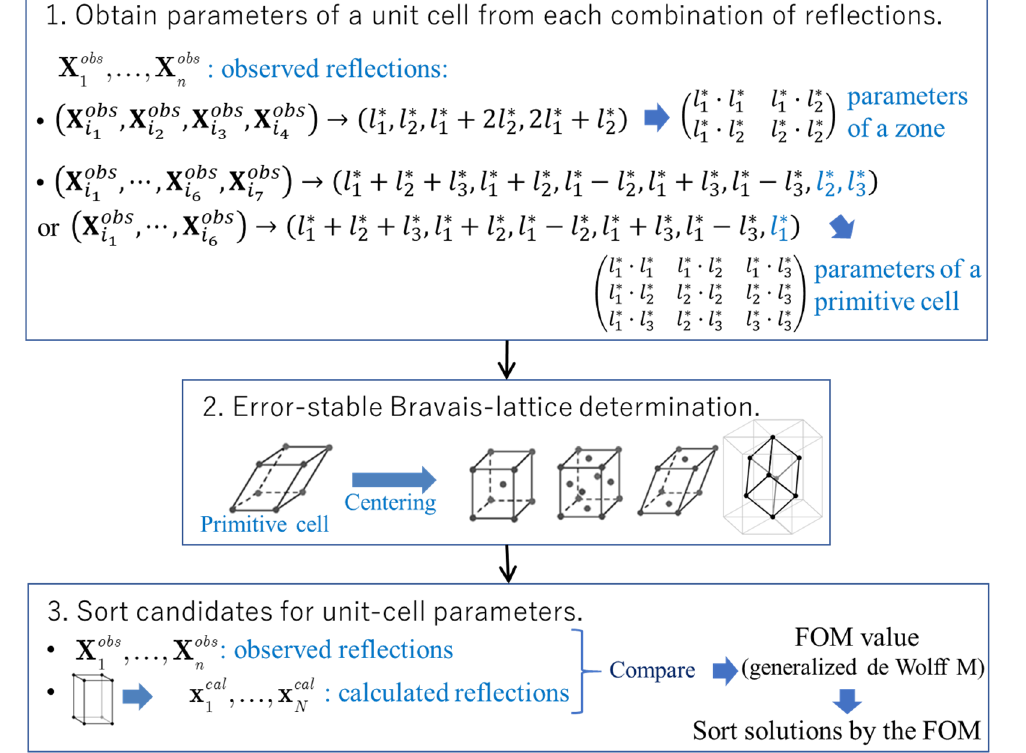
Figure 1. Common mathematical framework of our indexing